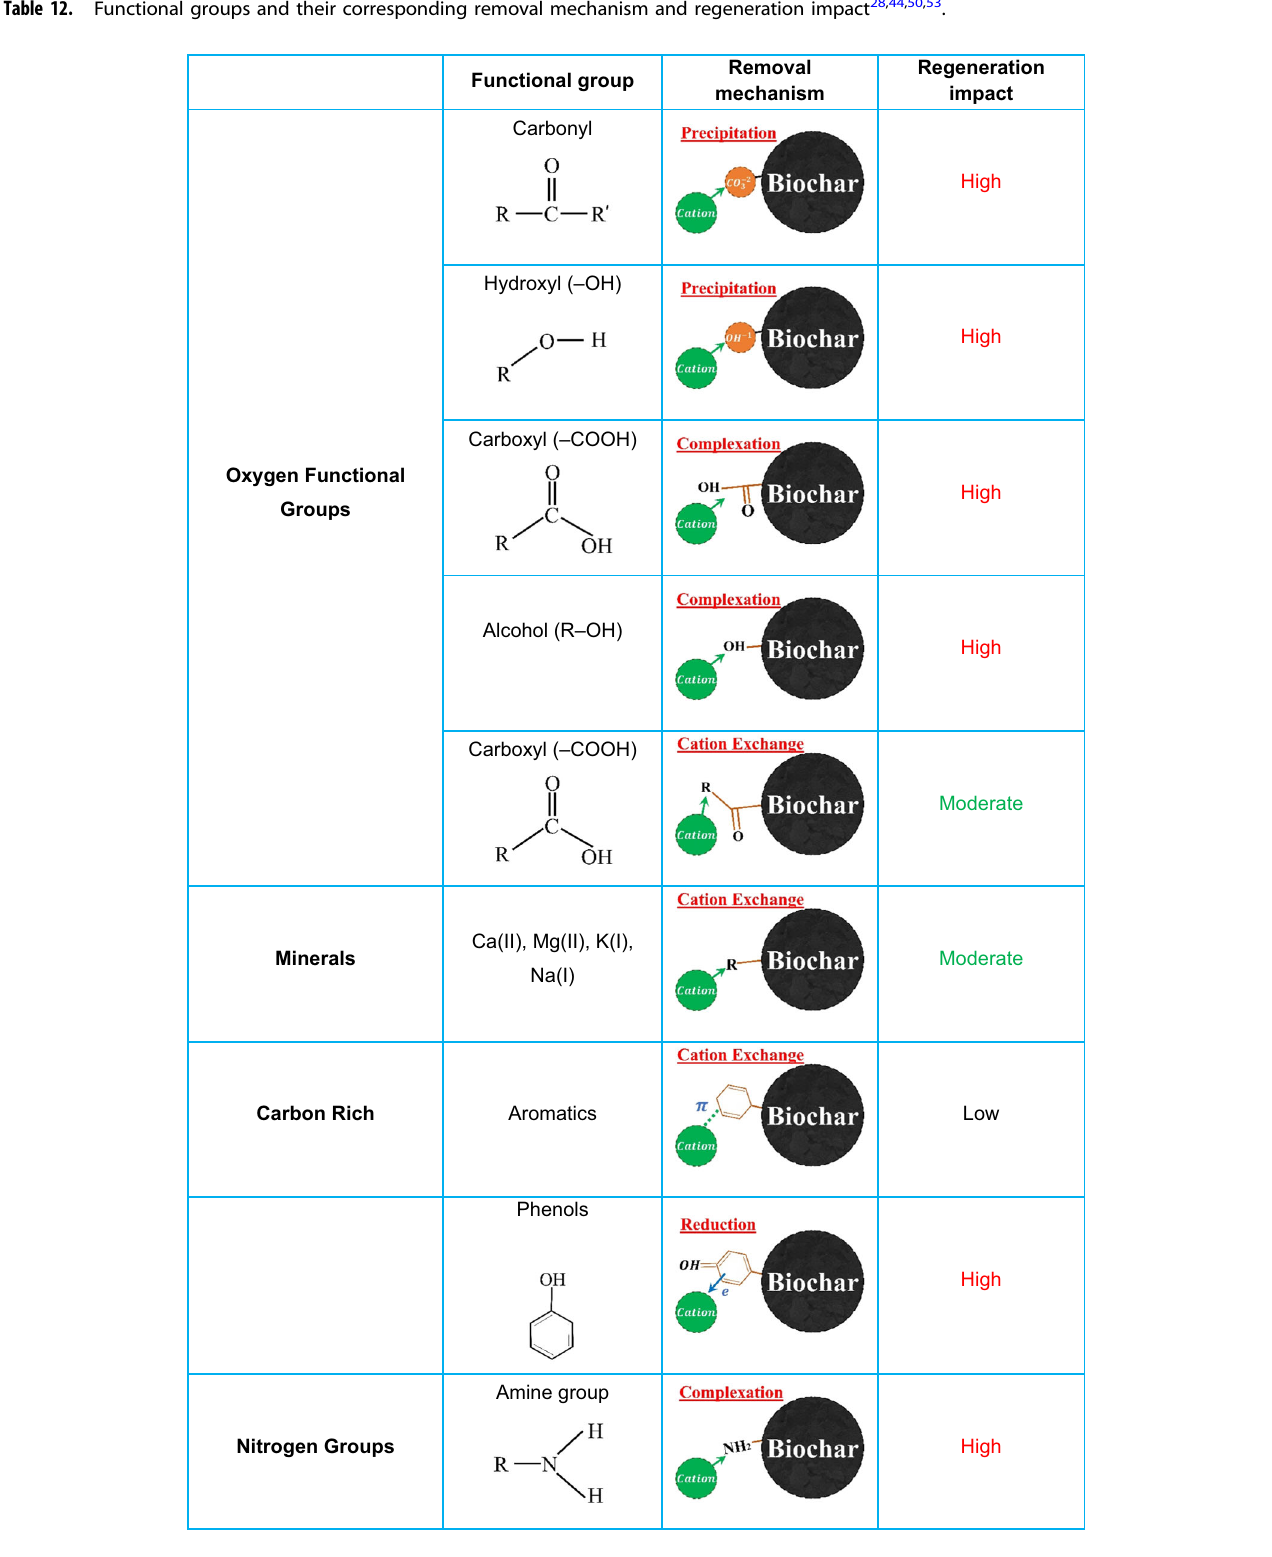
Table 12. Functional groups and their corresponding removal mechanism and regeneration impact 28,44,50,53